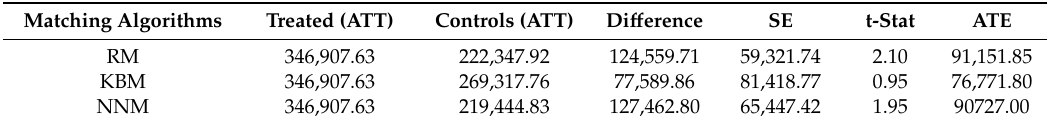
Table 3. Matching algorithms results.